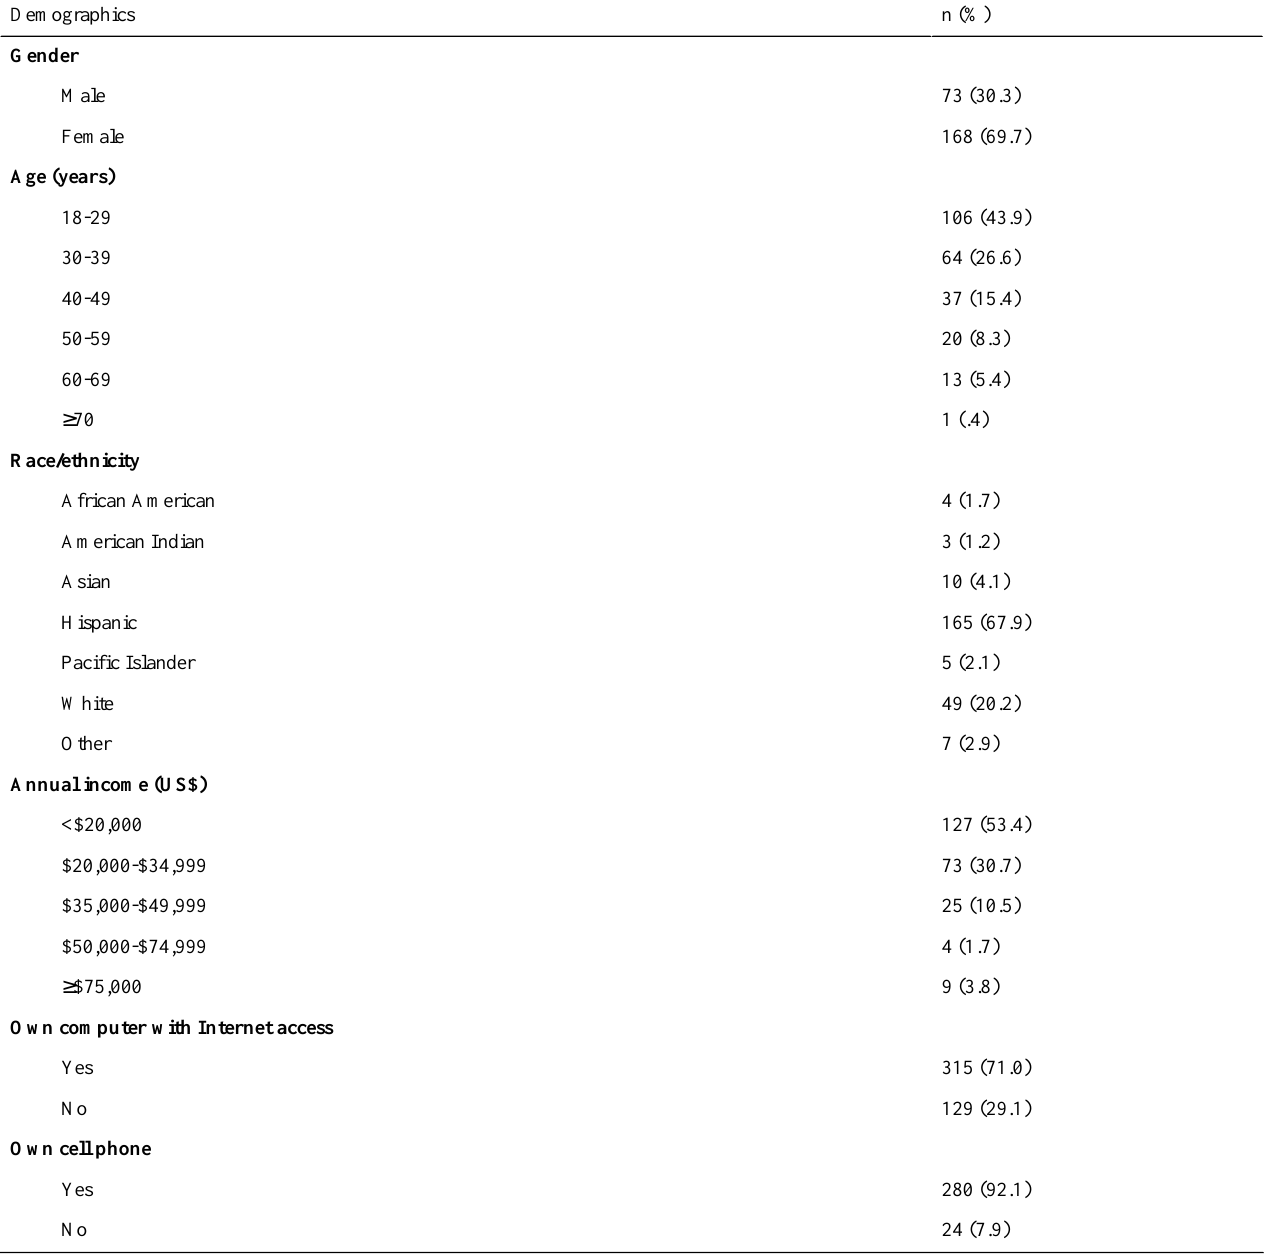
Table 1. Demographic characteristics of the study participants